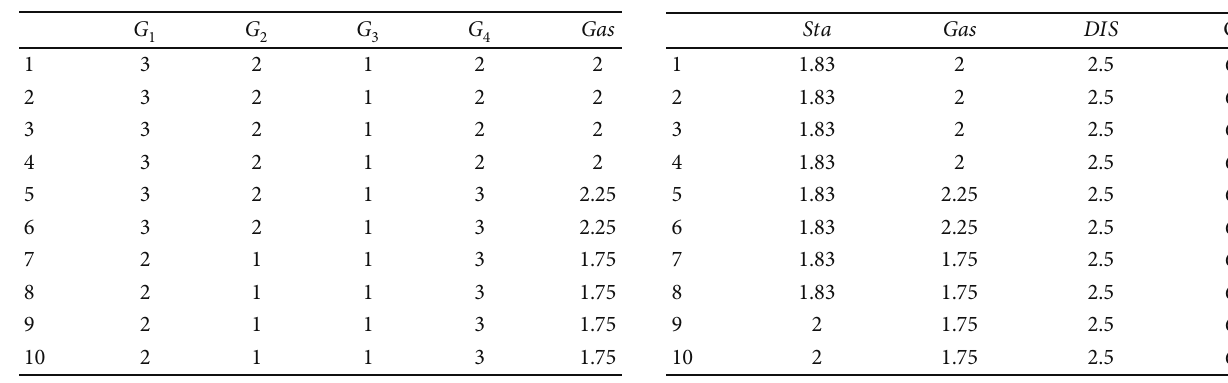
Table 3: Gas parameter strength calculation process.